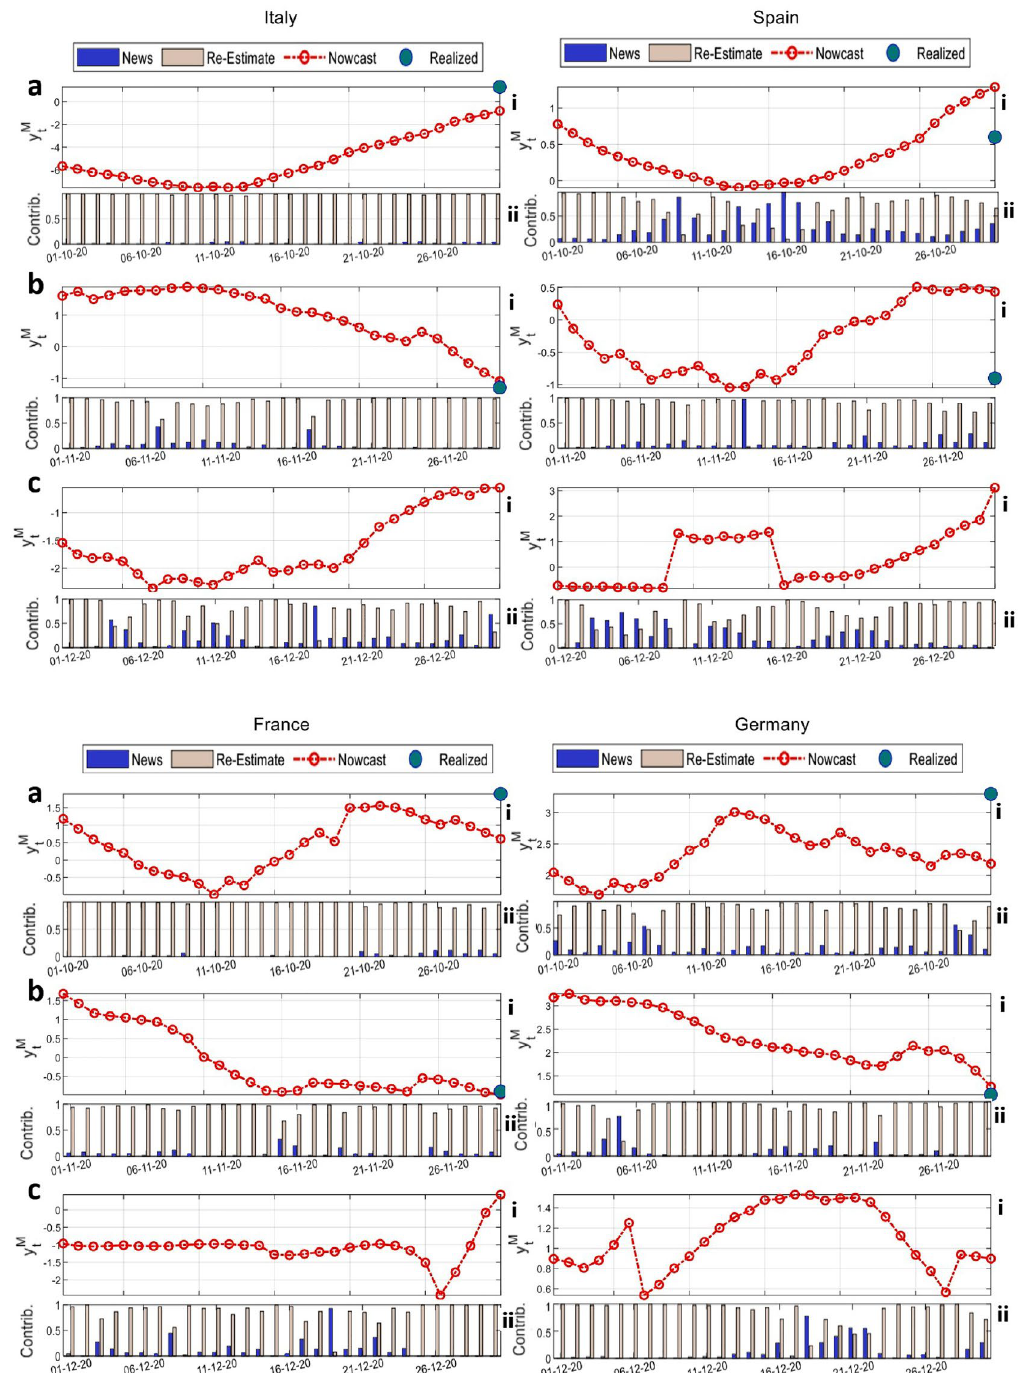
Figure 7. Line diagrams and bar-charts of nowcasting and forecasting results. The line diagrams report the time series of nowcasts and forecasts of the Industrial Production Index changes for Italy, Spain, France and Germany. In particular, panels ( a ) and ( b ) show the nowcasting results for the months of October and November 2020, respectively, while panel ( c ) displays the forecasting results for December 2020, for which no official data is available yet. Red lines in panels ( i ) illustrate the dynamics of the daily nowcasts (and forecasts) for the change in Industrial Production Index ( y M t ). Colored bars in panels ( ii ) represent the contribution ( Contrib .) of each component according to Eq. 1 to the daily change in the Industrial Production Index in relative terms. The news effect is reported as a blue bar while the re-estimate contribution is in pink color. Results are obtained by selecting, for each country, the best performing model in terms of mean squared error as per the model selection procedure illustrated in Fig.